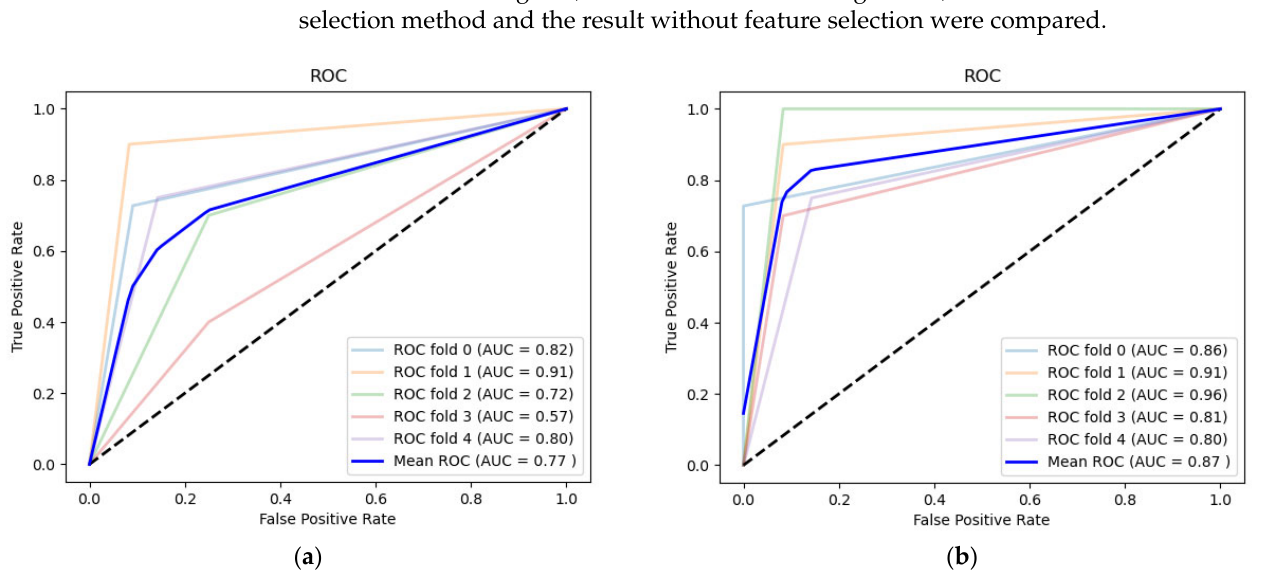
( b ) Figure 6. ROC curve of DNN: ( a ) non ‐ feature selection; ( b ) GA1.